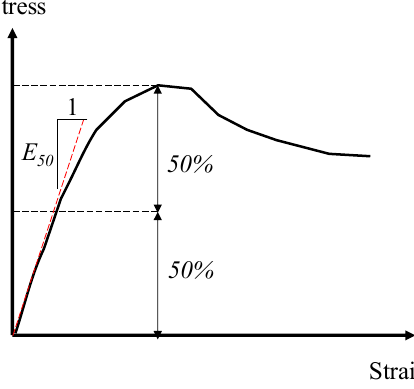
Figure 4. The definition of Young’s modulus, E 50 .